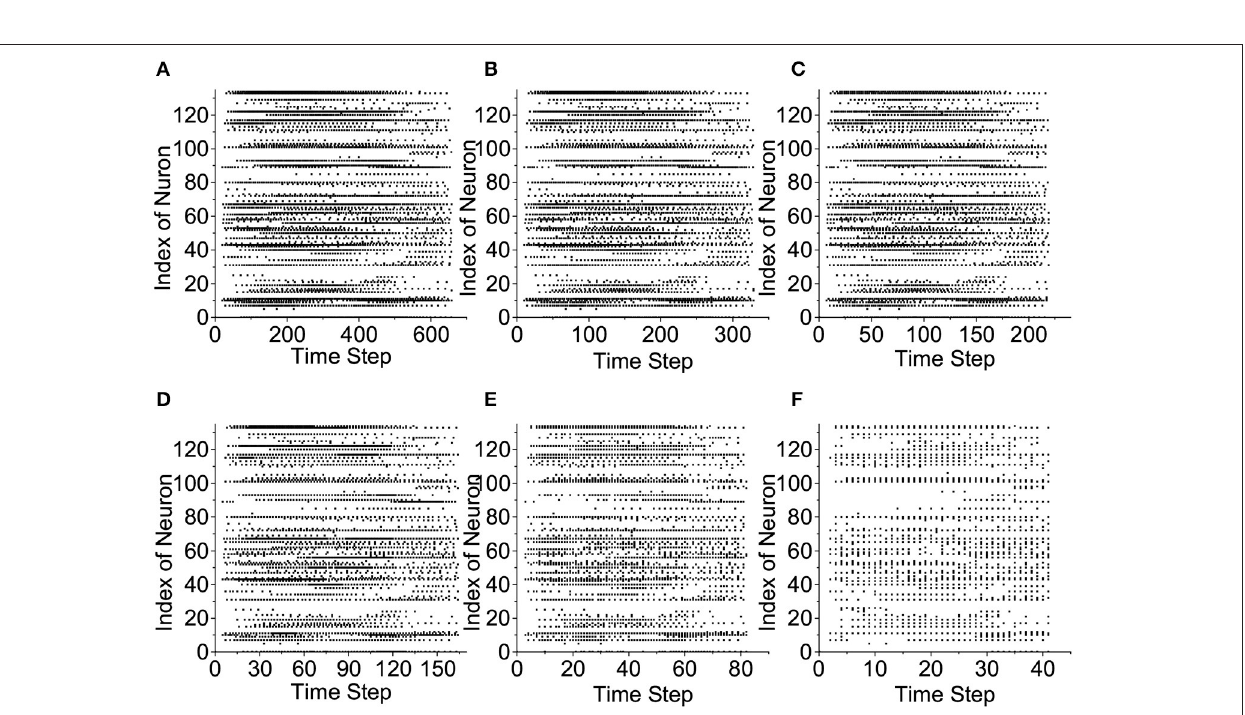
FIGURE 10 | Reservoir response vs. compression ratio. (A) No compression, (B) 2:1 compression, (C) 3:1 compression, (D) 4:1 compression, (E) 8:1 compression, and (F) 16:1 compression.